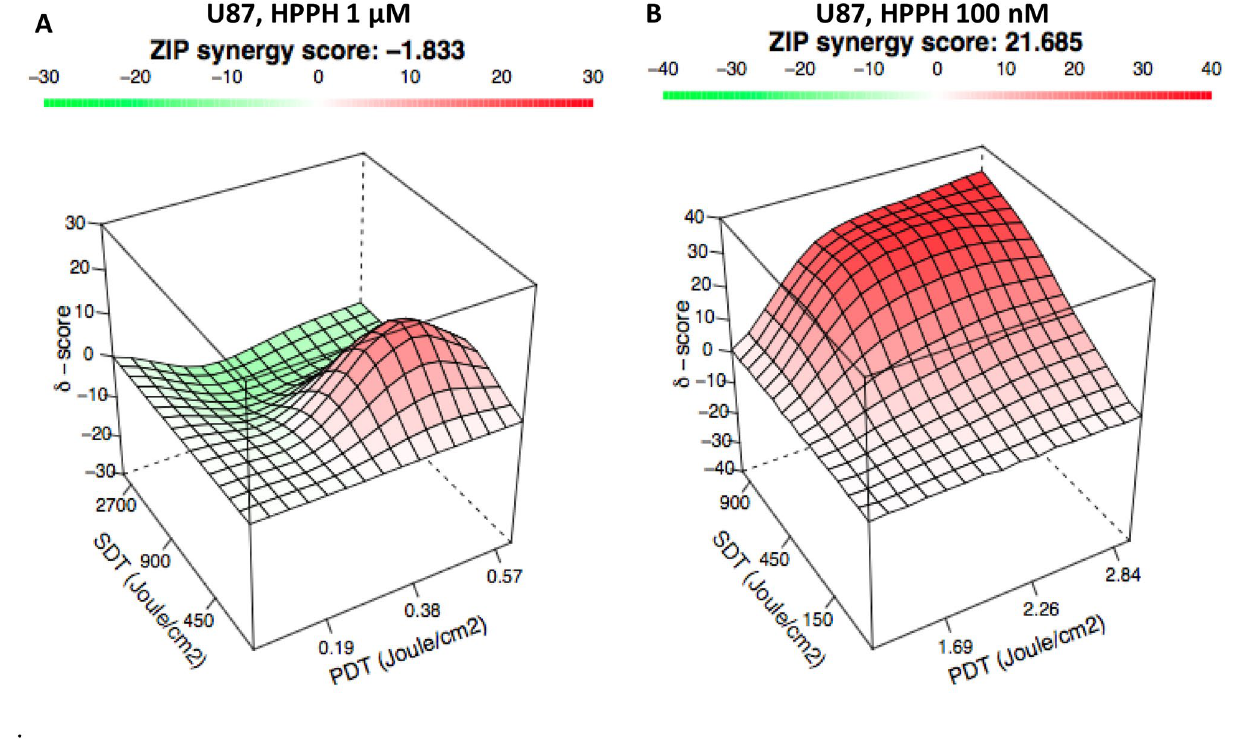
Figure 5. Combination of ultrasound and light yields synergism in vitro response. Cells were plated and incubated with either ( A ) 1 µM or ( B ) 100 nM ( B ) of HPPH. After 24 h of incubation, the cells were exposed to either light, sound, or both. The plates that received both light and ultrasound were first exposed to 665 nm light, then rested for 30 min, then received the dose of ultrasound. 24 h post light/ultrasound exposure, the cells were counted using trypan blue assay. The synergy is calculated utilizing Synergyfinder web application. δ score between − 10 and 10 correspond to an additive response (light green, white and red regions), δ score less than − 10 corresponds to an antagonistic response (dark green), and a δ score greater than 10 corresponds to a synergistic response. No combination of SDT and PDT yields an antagonistic response, but 2700 J/cm of SDT and 0.36 J/cm of PDT yielded the lowest δ score of − 9.49.